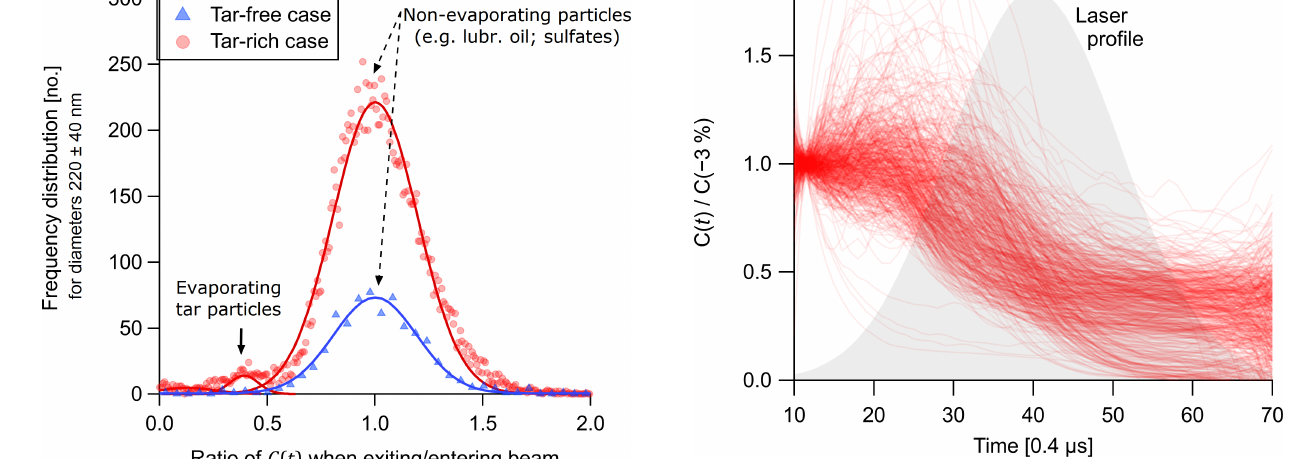
Figure 3. C(t) for all particles with R ( − 20%, 20%) < 0 . 5 in Fig. 2, normalized to C ( − 3%) (which is normally using for coating- thickness analysis). Each transparent red line represents C(t) for a single particle, as was also shown in the lowest panel of Fig.